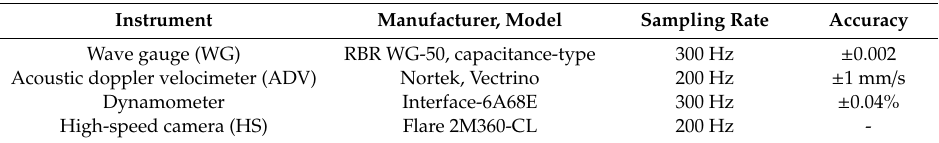
Table 1. Instruments used in the experimental